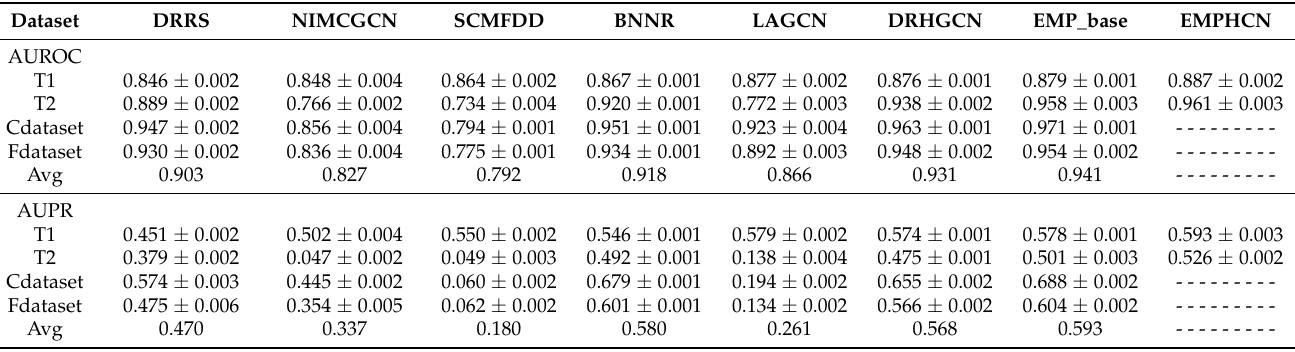
Figure 4. Performance comparison with all methods by 10-fold-cross-validation on datasets T1 and T2. ( a ) AUC comparison of different methods. ( b ) AUPR comparison of different methods. ( c ) Box-plot comparison of average AUCs ( d ) Box-plot comparison of average AUPRs. Table 2. Result comparison of 10-fold cross-validation experiments with different methods on benchmark datasets.